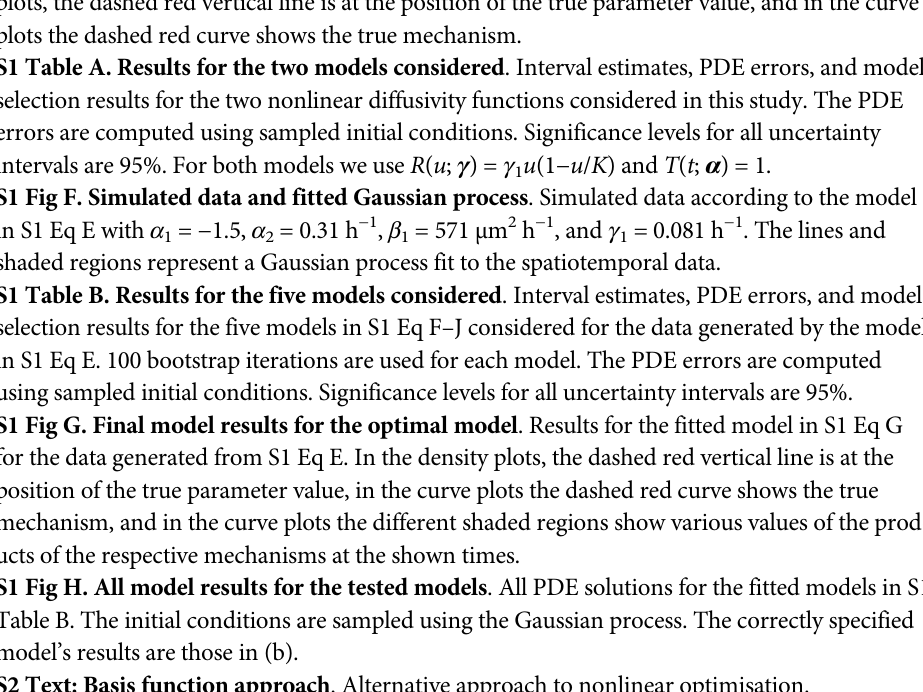
S1 Table A. Results for the two models considered . Interval estimates, PDE errors, and model selection results for the two nonlinear diffusivity functions considered in this study. The PDE errors are computed using sampled initial conditions. Significance levels for all uncertainty